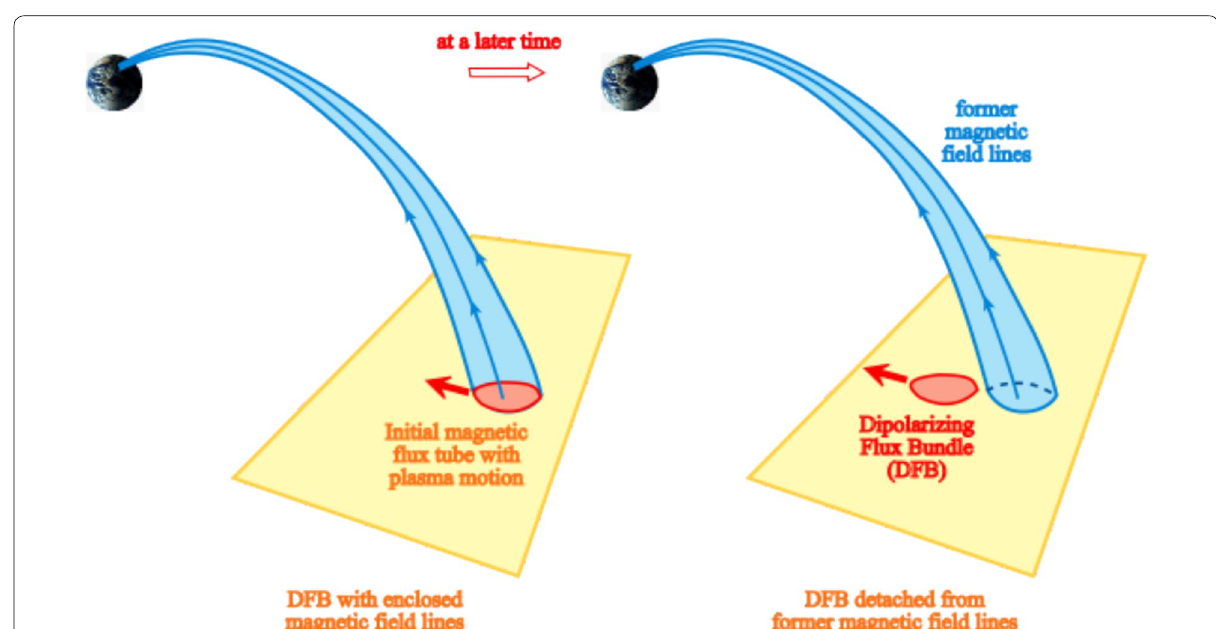
Fig. 2 Schematic diagram to illustrate the lack of magnetic flux transport over a substantial distance by a dipolarizing flux bundle because of the severe departure from the frozen-in